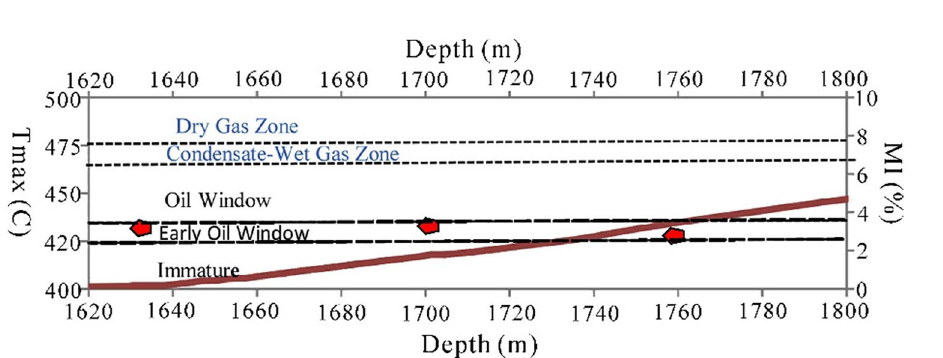
Figure 10. Graphical comparison between the calculated maturity index (MI) and T max in Bijnot-1 (red dots represent T max and maroon line for